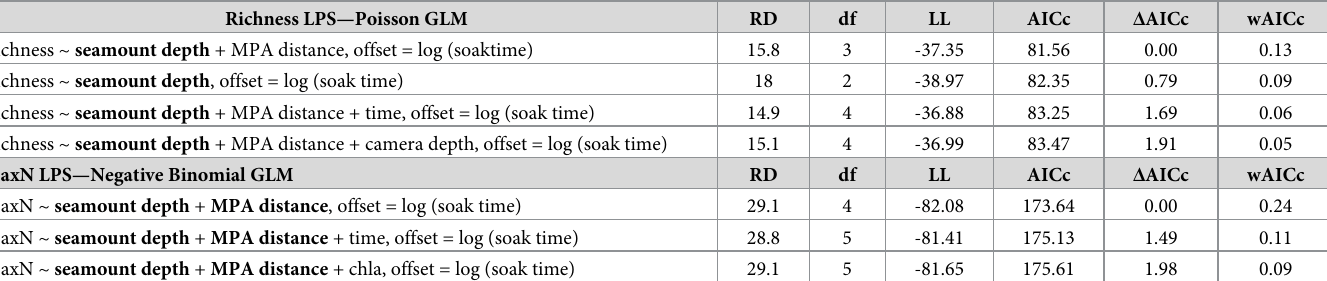
Table 3. Comparison of optimal generalised linear models (GLM), using a Poisson and a Negative Binomial error distribution, of large pelagic species (LPS) rich- ness and relative abundance (MaxN), respectively. Richness LPS—Poisson GLM RD df LL AICc Δ